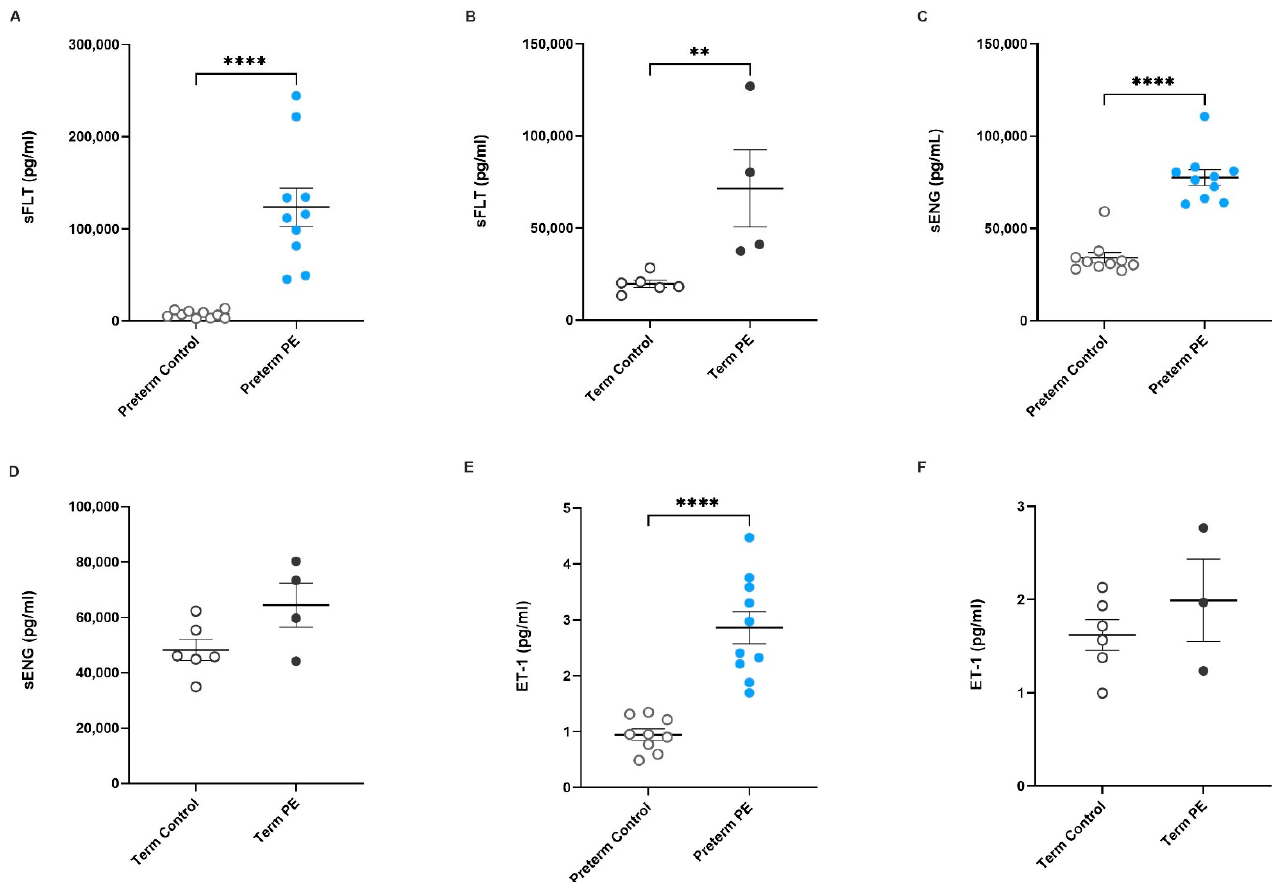
Figure 1. Antiangiogenic factors sFlt-1 and sENG, and potent vasoconstrictor ET-1, are increased in serum obtained from pregnancies complicated by preeclampsia. Circulating sFlt-1 concentrations in serum from pregnancies complicated by ( A ) preterm preeclampsia ( ) or ( B ) term preeclampsia ( ) and from patients with uncomplicated pregnancies at matched gestation (preterm and term controls;